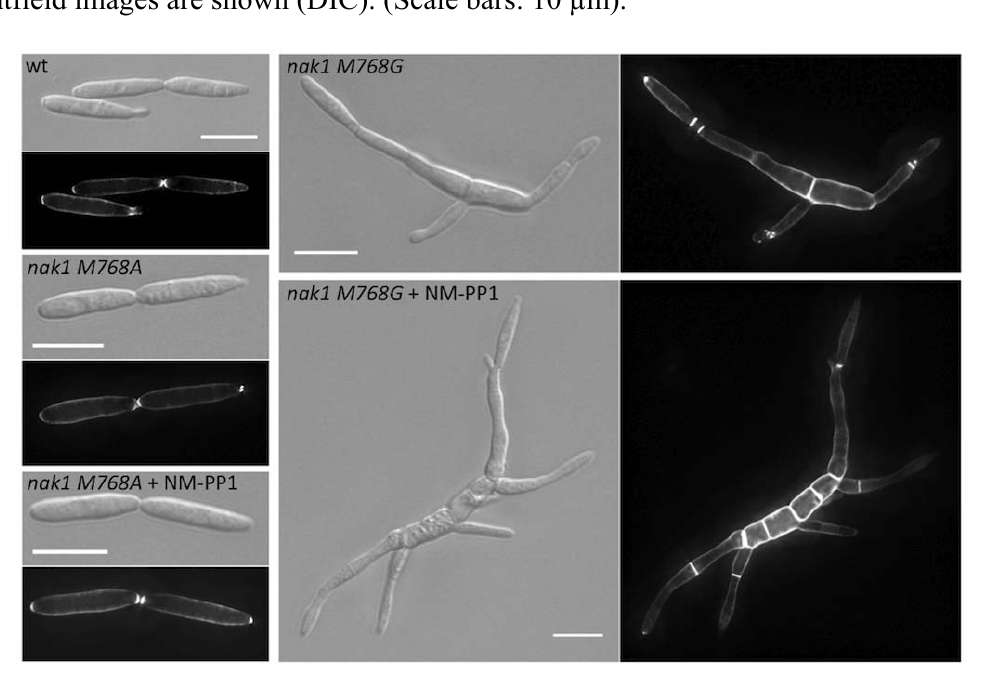
Figure 3. Gatekeeper mutations M768A and M768G in Nak1 did not lead to analog-sensitive kinases. Cells expressing either nak1 M768A or nak1 M768G were grown to an OD = 0.1. After addition of the inhibitor cells were grown for 8 h. Representative 600 brightfield images are shown (DIC). (Scale bars: 10